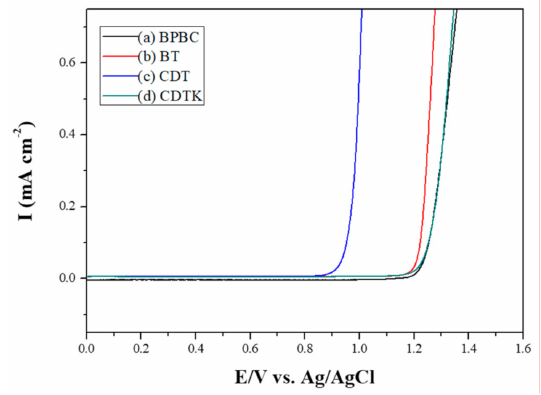
Figure 3. Electrooxidation curves of ( a ) 2 mM BPBC, ( b ) 2 mM BT, ( c ) 2 mM CDT, and ( d ) 2 mM CDTK in 0.2 M LiClO 4 of ACN/DCM solution (ACN/DCM = 4:1, by volume) at 100 mV s − 1 .